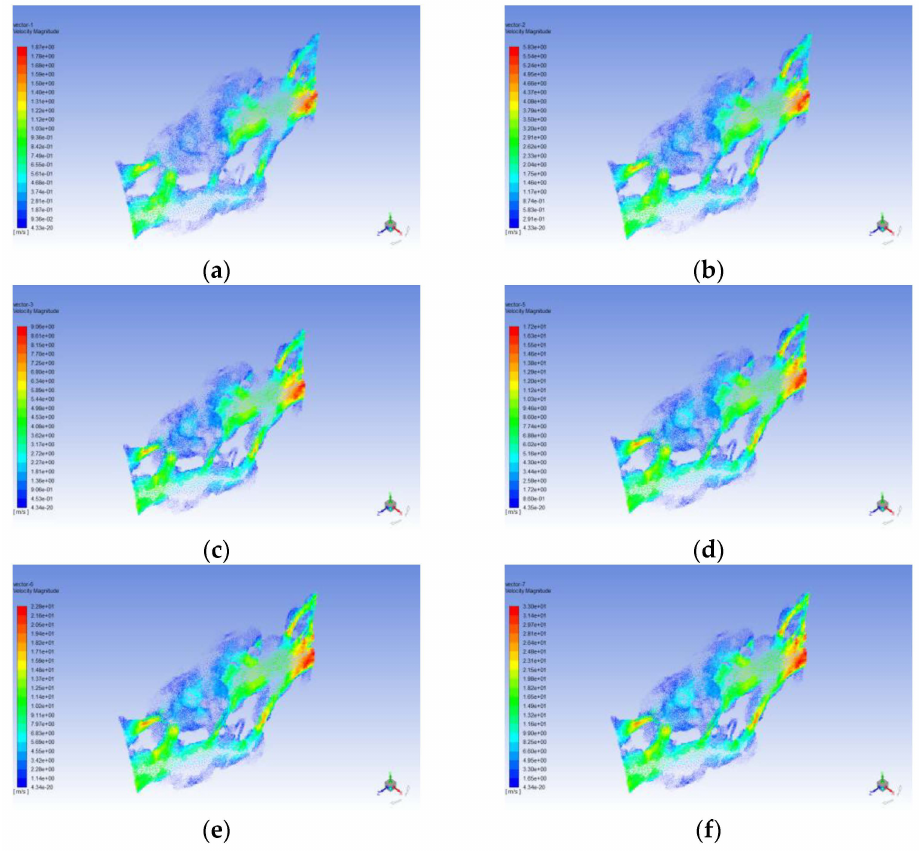
Figure 6. z negative inlet velocity vector diagram:( a ) 0.1 Mpa speed vector. ( b ) 0.5 Mpa speed vector. ( c ) 1 Mpa speed vector. ( d ) 3 Mpa speed vector. ( e ) 5 Mpa speed vector. ( f ) 10 Mpa speed